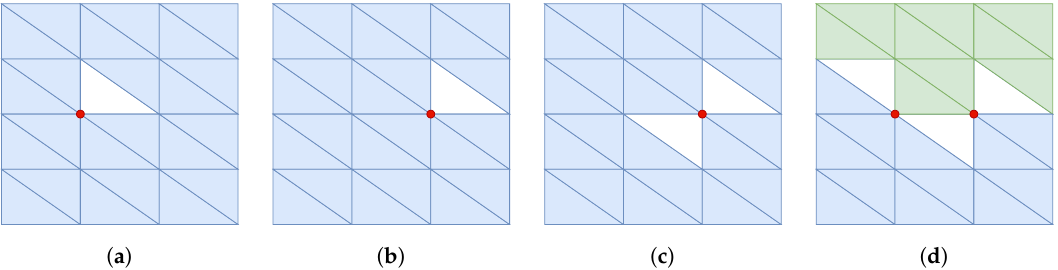
Figure 6. Example non-manifold meshes that exhibit condition (1) violations. Red vertices specifically show examples where the vertex triangle set is not fully edge-connected. ( a – c ) will extract any missing triangles as holes from the blue triangular segment; ( d ) The missing triangles in this mesh also cause condition (1) violations but will not be captured as holes. They cause the green and blue portion of the mesh to not be edge-connected for region growing in Section 7.1. They will be extracted as two separate segments with no holes in their respective interiors .